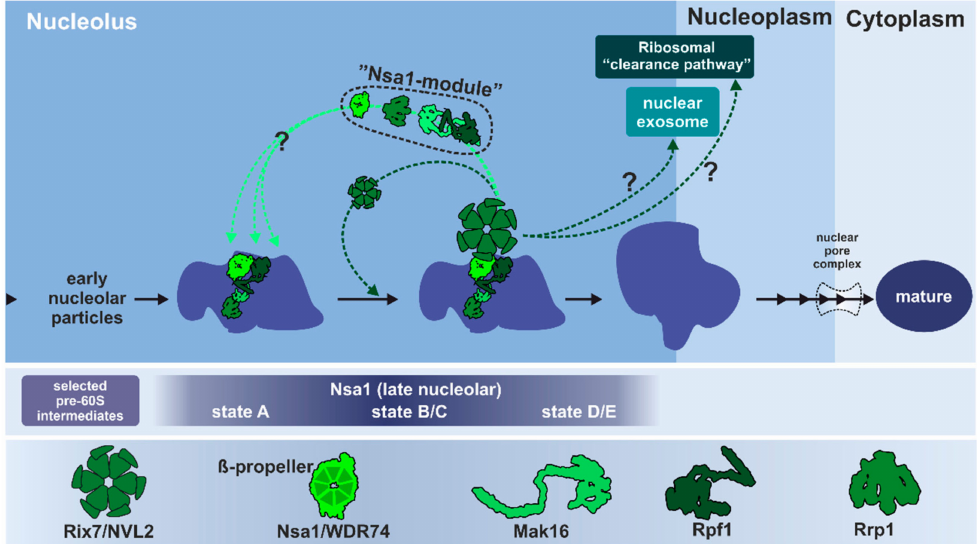
Figure 6. Remodeling of the nucleolar Nsa1-particle by Rix7. S. cerevisiae Rix7 joins late nucleolar Nsa1-particles to trigger the release of the β -propeller protein Nsa1, which is part of assembly factor sub-complex (“Nsa1-module”) [31]. Timely release of these factors is considered a prerequisite for correct folding of the pre-rRNA as well as the formation of the PET, which at this early stage is occupied by Rpf1. It is, however, not determined if these four proteins join the particle together and also if they are released together at the exact same stage. As discussed in this section, Rix7 could potentially also be connected to a ribosomal clearance pathway as part of the ribosomal quality control. Activity of the mammalian Rix7-orthologue nuclear VCP-like protein 2 (NVL2) is needed for the assembly of the nuclear exosome which also contributes to 60S